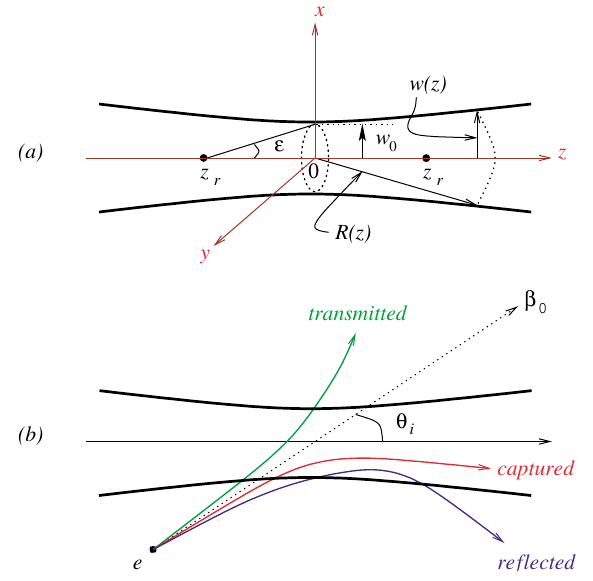
FIG. 1. (Color) (a) Geometry of the Gaussian beam. (b) A schematic diagram of the electron